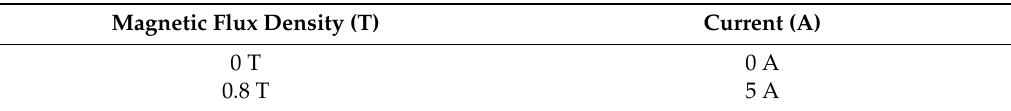
Table 2. Magnetic flux density.